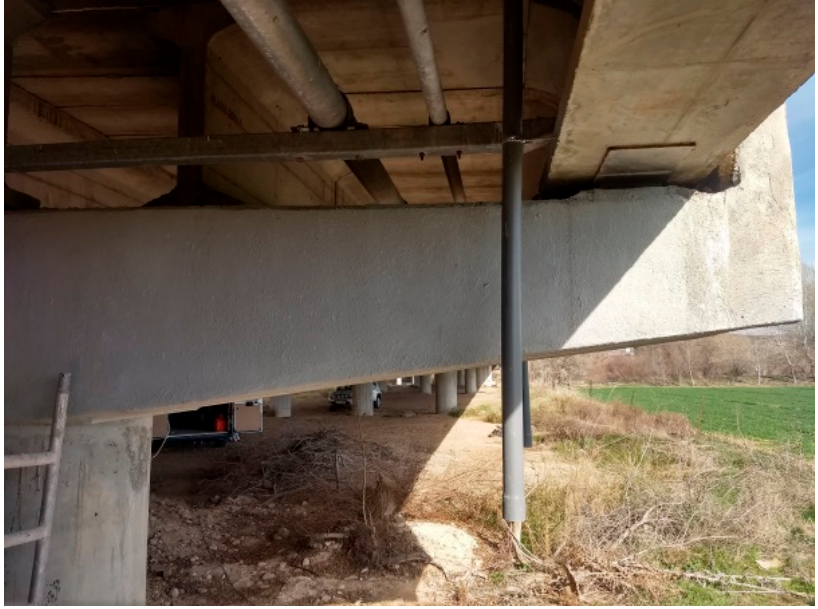
Figure 7. Photograph of concrete member 2 weeks after repair (photo taken by